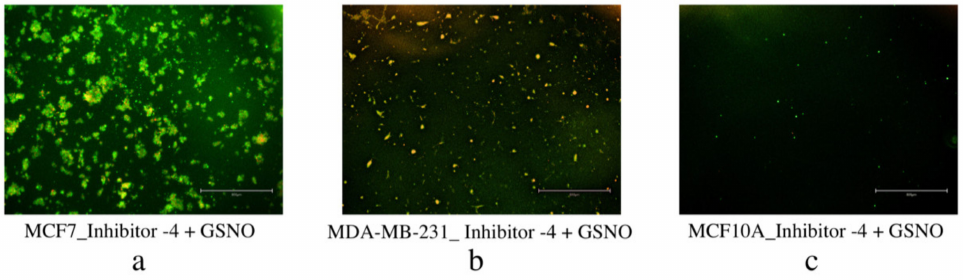
Figure 13. Detection of apoptosis in MCF7 ( a ), MDA-MB-231 ( b ), and MCF10A ( c ) cells by Annexin V/FITC and PI staining. Cells were treated with the combination therapeutic (Group 2), then stained with Annexin V/FITC (green) and PI (red) and imaged with fluorescence microscopy.